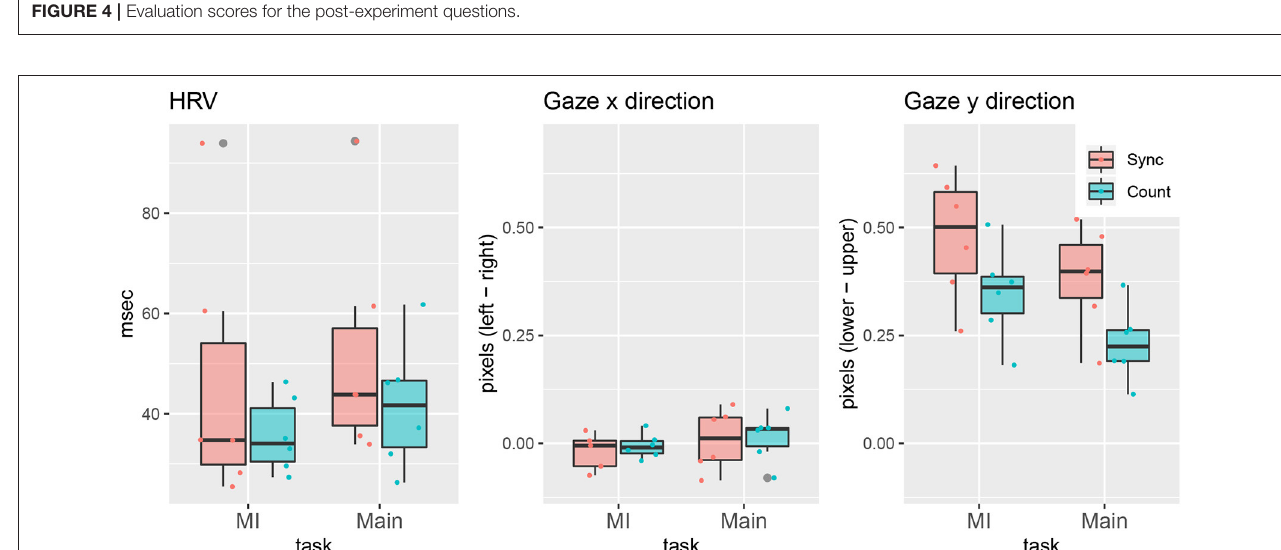
FIGURE 4 | Evaluation scores for the post-experiment questions.